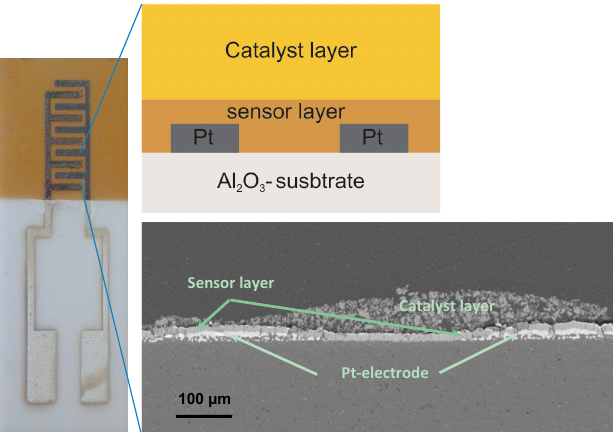
Figure 1. Sensor platform consisting of interdigitated Pt-electrodes (IDE), a semiconducting oxide sensor layer, and a catalytic filter layer. The SEM micrograph shows these layers in the cross-section as above, schematically specified: top layer: BaTi 0.9 Rh 0.1 O 3 catalytic layer, middle layer: Al-doped TiO 2 sensor layer and bottom layer: Pt-electrode on alumina